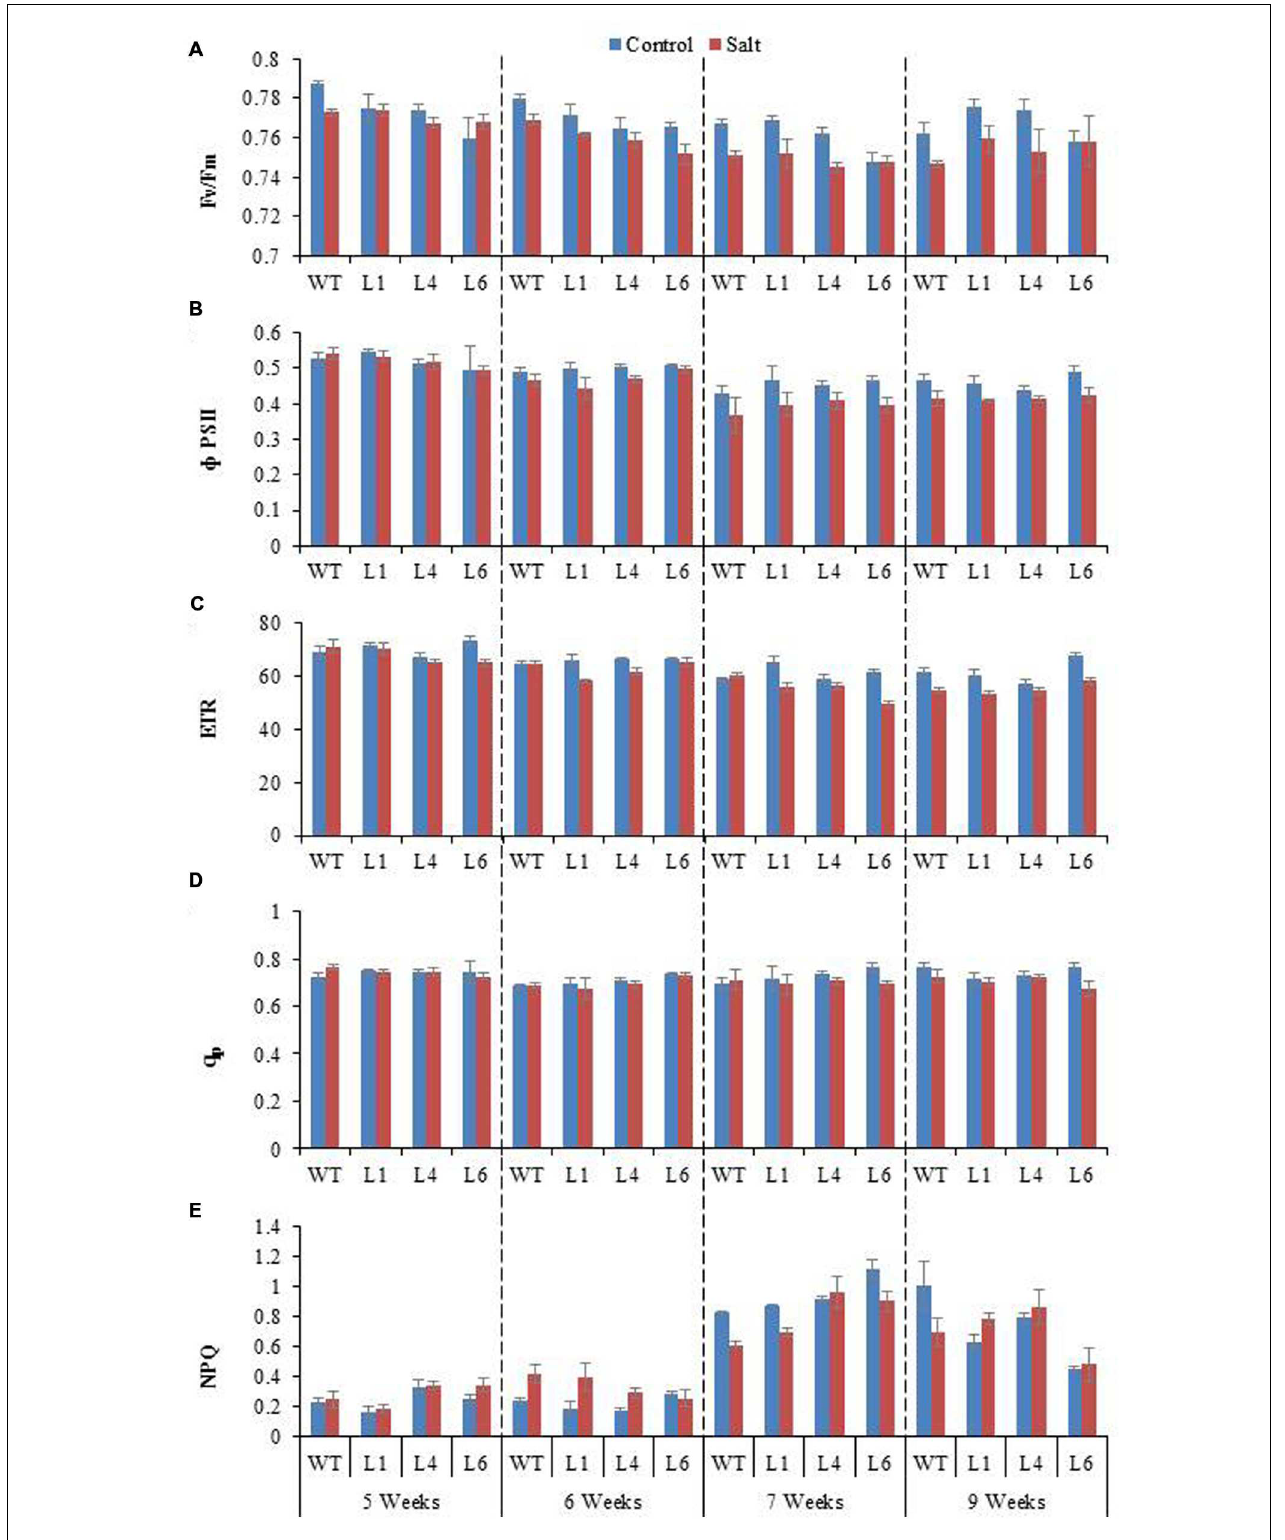
FIGURE 9 | Chlorophyll fluorescence analysis of WT and JcPR-10a transgenic lines (L1, L4, and L6) in response to the gradual exposure of stress from 5 to 7 weeks and on growth restoration by removal of stress (9 weeks). (A) F v / F m ratio, (B) (cid:56) PSII, (C) Photosynthetic electron transport rate (ETR), (D) Photochemical quenching (q p ) and (E) non-photochemical quenching (NPQ).